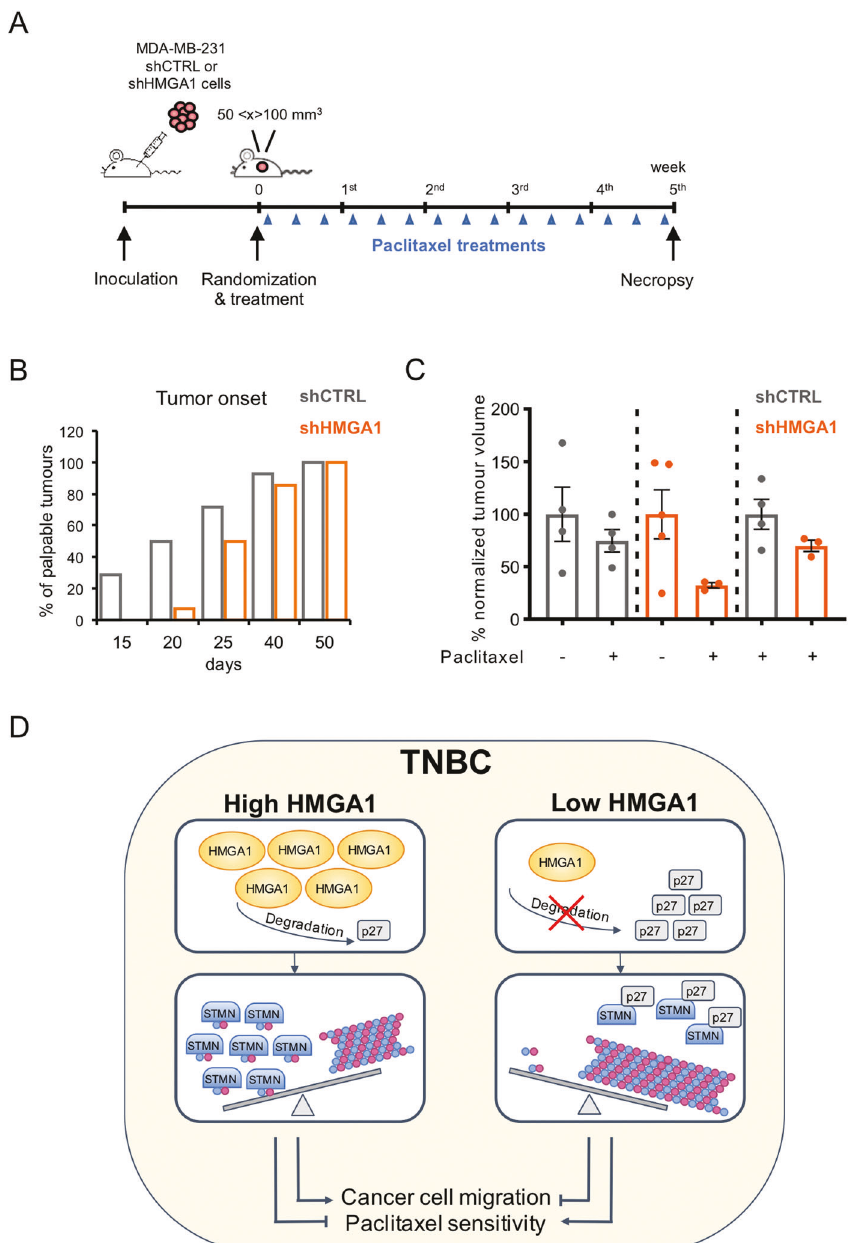
Fig. 6 Depletion of HMGA1 enhances sensitivity to paclitaxel in a xenograft mouse model. A Flow chart of the experimental BC mouse model for the treatment with paclitaxel. Mice were inoculated with MDA-MB-231/TetR shCTRL or shHMGA1 inducible clones and, when the tumour masses reached 50 – 100 mm 3 of tumour volume, they were randomly grouped and then treated with paclitaxel. B Evaluation of tumour onset. The graph shows the different timing of tumour onset (tumour mass of 50 – 100 mm 3 ) in MDA-MB-231 shCTRL and MDA-MB-231 shHMGA1 injected cells ( n = 14 tumours). C Graph representing the percentage of volume masses at the endpoint of the treatment, comparing shCTRL ( n = 4) vs. shCTRL + paclitaxel ( n = 4), shHMGA1 ( n = 5) vs. shHMGA1 + paclitaxel ( n = 3), and shCTRL + paclitaxel vs. shHMGA1 + paclitaxel. Tumour data have been normalized on the fi rst day of the treatment. Data are presented as mean ± SEM. D Scheme illustrating the regulation of HMGA1 on p27 and stathmin and its effect on cancer cell migration and paclitaxel sensitivity (blue and pink dots represent free and polymerized